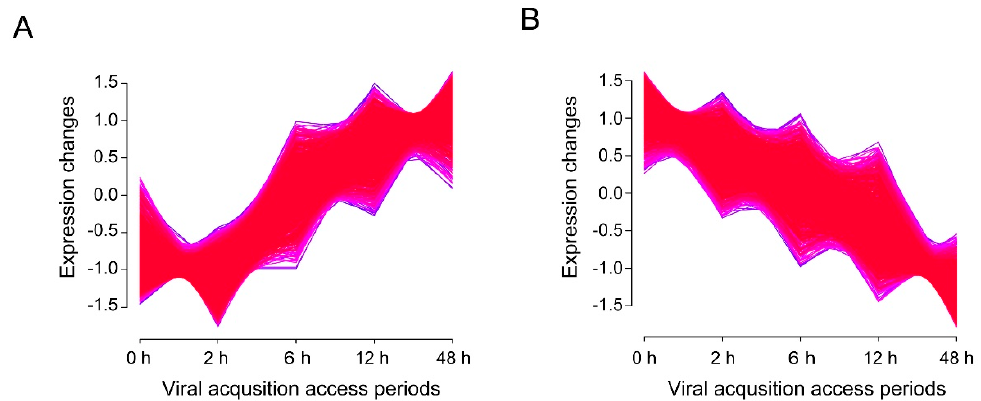
Figure 5. Time-associated gene clusters. For di ff erent treatments, genes with similar expression patterns were clustered into di ff erent groups. ( A ) Expression pattern of 1168 continually up-regulated genes. ( B ) Expression pattern of 1312 continually down-regulated genes. Table 2. The expression profiles of the temporally up-regulated genes encoding transporters after di ff erent AAPs on TYLCV-infected plants.